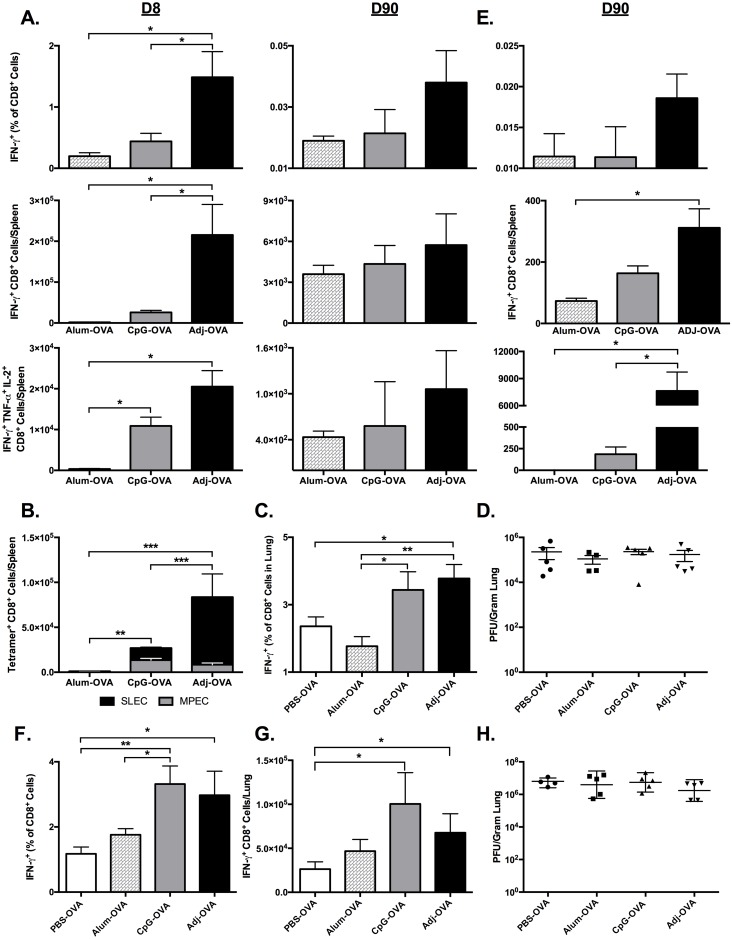
Kinetics of Primary CTL Responses and Viral Control after Subcutaneous Vaccination with OVA.(A-D) Prime-only Vaccination. C57BL/6 mice were vaccinated by subcutaneous injection of 10 μg ovalbumin in PBS alone or supplemented with 5% Adjuplex or 10 μg CpG. 3–5 mice/group were sacrificed at 8 and 90 days after vaccination. (A) The percentages of SIINFEKL-specific IFN-γ+ TNF-α+ and IL-2+ CD8 T cells in spleens were quantified by intracellular cytokine staining at day 8 and 90 after vaccination. (B) At day 7 after vaccination, splenocytes were stained with anti-CD8, Kb/SIINFEKL tetramers, anti-CD127 and anti-KLRG-1. The percentages of short-lived effector cells (SLECs; CD127LO/KLRG-1HI) and memory precursor effector cells (MPECs; CD127HI/KLRG-1LO) among tetramer-binding SIINFEKL-specific CD8 T cells were quantified by flow cytometry. Data shows the total numbers of SLECs and MPECs in spleens of vaccinated mice. (C-D) Secondary CTL recall responses and lung viral titers after prime-only SQ vaccination and influenza challenge. C57BL/6 mice were vaccinated by SQ injection of 10 μg ovalbumin in PBS alone or supplemented with 5% Adjuplex or 10 μg CpG. 90 days after vaccination, mice were challenged by IN administration of 500 PFU of recombinant influenza A/PR/8/34-OT-I H1N1 expressing the OVA SIINFEKL peptide. 6 days after challenge, 3–5 mice/group were sacrificed and lungs were collected to quantify SIINFEKL-specific CTLs and viral titers. (C) Frequency of SIINFEKL-specific IFN-γ+ CD8+ T cells among all CD8+ lung mononuclear cells at 6 days after challenge. (D) Lung viral titers expressed as plaque-forming-units (PFU) per gram of lung at 6 days after challenge. * indicates p<0.05, ** indicates p<0.01, *** indicates p<0.001. (E-H) Prime-boost vaccination. C57BL/6 mice were vaccinated by SQ injection of 10 μg ovalbumin in PBS alone or supplemented with 5% Adjuplex or 10 μg CpG, and boosted 30 days later. (E) 3–5 mice/group were sacrificed at 90 days after booster vaccination. Graph shows percentages and/or absolute number of SIINFEKL-specific IFN-γ+ TNF-α+ and IL-2+ CD8 T cells in spleen. (F-H) 90 days after vaccination, mice were challenged by IN administration of 500 PFU of recombinant influenza A/PR/8/34-OT-I H1N1 expressing the OVA SIINFEKL peptide. 6 days after challenge, 3–5 mice/group were sacrificed and lungs were collected for quantification of CTLs and viral load. (F) Frequency of SIINFEKL-specific IFN-γ+ CD8+ T cells among all CD8+ lung mononuclear cells. (G) Absolute numbers SIINFEKL-specific IFN-γ+ CD8 T cells in lung. (H) Lung viral titers expressed as plaque-forming-units (PFU) per gram of lung. * indicates p<0.05, ** indicates p<0.01. Data is representative of two independent experiments.